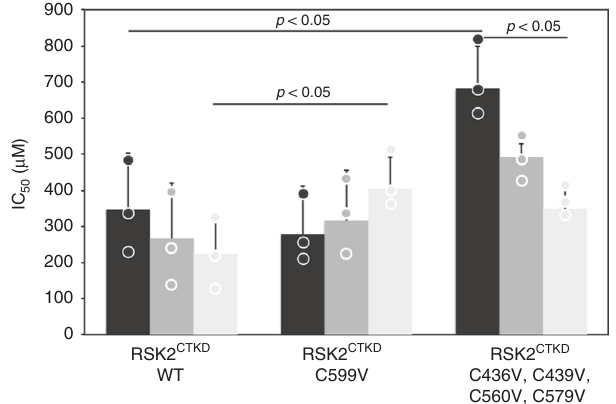
Fig. 3 Time course of DMF inhibition. In vitro determination of apparent IC 50 values of DMF on RSK2 CTKD activity following incubation with DMF at different time points (1 h: black, 24 h: dark grey, and 48 h light grey) prior to ERK2 activation ( n = 3, all data points indicated by circles)